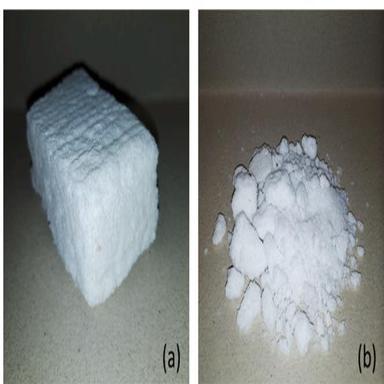
Sample of the aerogel composite in (a) block form and (b) fragments.